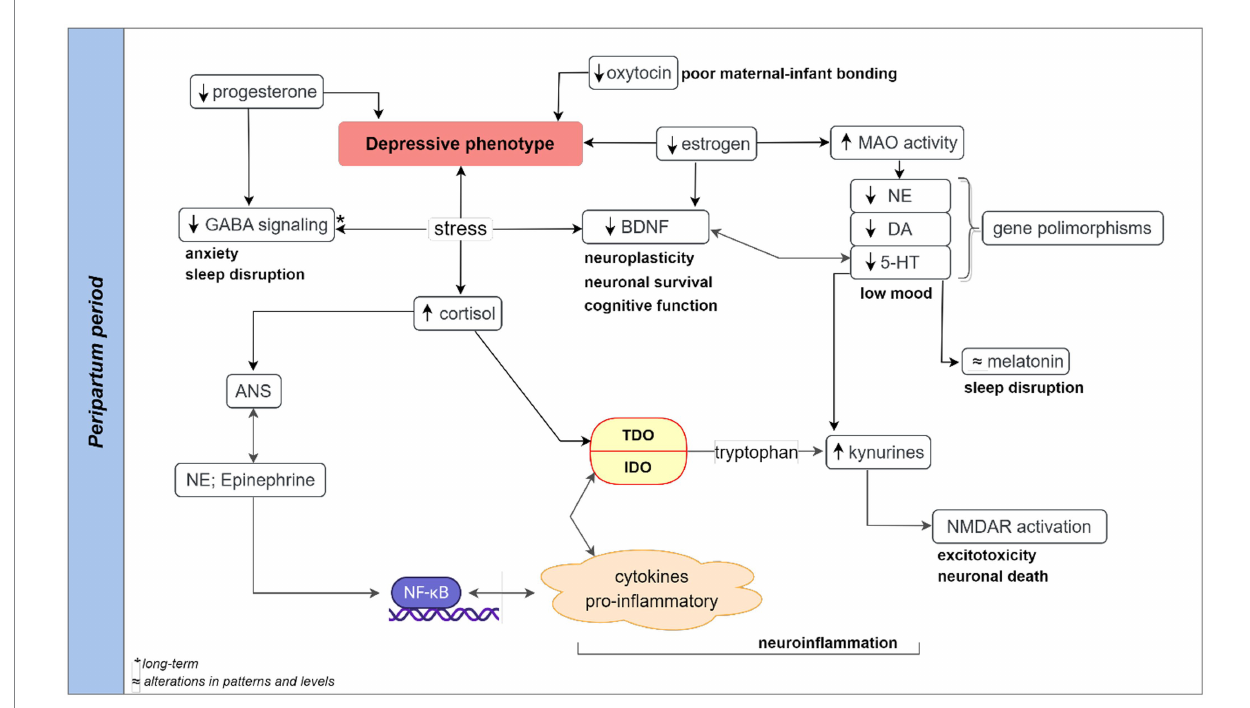
FIGURE 2 Hypothetical pathways contributing to peripartum depressive readouts. Stress-induced activation of the HPA axis could lead to a chain of events involving cortisol release and autonomic nervous system (ANS) release of catecholamines. Both HPA and ANS are highly coordinated and interconnected with the overall impact on neuroendocrine (reduced levels of progesterone, oxytocin, and estrogen), monoamines (norepinephrine, serotonin, and dopamine), and neuroinflammation (increased level of inflammatory cytokines) at the peripartum period. Long-term stress and reduced progesterone may lead to decreased GABAergic signaling, contributing to peripartum sleep disruption and anxiety. A high level of stress-induced immune-inflammatory activity could shift tryptophan-serotonin-melatonin metabolism to metabolites-driven kynurenine pathway. The downregulation of serotonin and melatonin synthesis coupled with the upregulation of kynurenic and quinolinic acid contribute to the depressive phenotype. The alterations in the tryptophan-kynurenine pathway can lead to excessive activation of N-Methyl-D-Aspartate receptor, inflammation, oxidative stress responses, and excitotoxicity leading to cellular damage, and depressive readouts in postpartum depression. A monoamine-lowering process with genetic polymorphism or a dramatic elevation of MAO-A following estrogen decline could potentiate stress-induced BDNF reductions increase the risk of neuronal damage and low mood. 5-HT, serotonin; ANS, autonomous nervous system; BDNF, brain-derived neurotrophic factor; DA, dopamine; GABA, gamma aminobutyric acid; HPA, hypothalamic–pituitary–adrenal; IDO, indoleamine 2,3-dioxygenase enzyme; MAO, Monoamine oxidase enzyme; NE, norepinephrine; NF- κ B, nuclear factor kappa B; NMDAR, N-Methyl-D-Aspartate receptor; TDO, tryptophan 2,3-dioxygenase